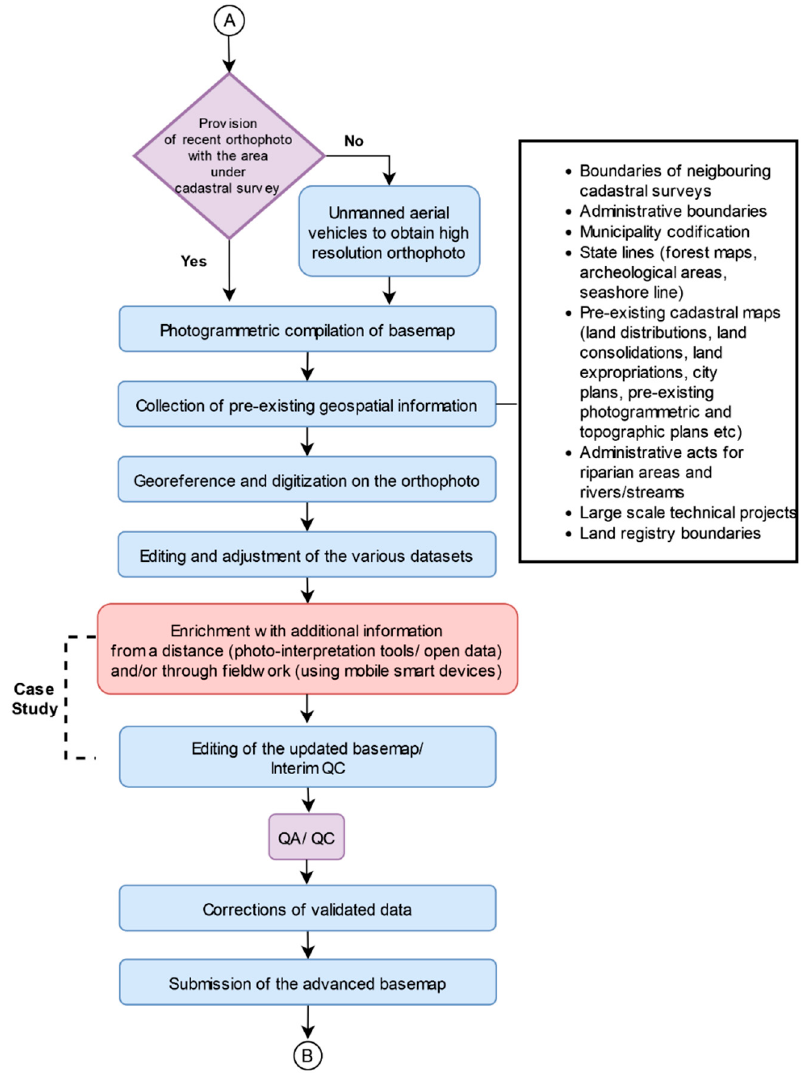
Figure 19. Proposed model for the compilation of an advanced crowdsourced basemap with the assistance of trained volunteers: NMCA’s actions (purple); professional’s actions (blue); volunteers’ actions (pink).